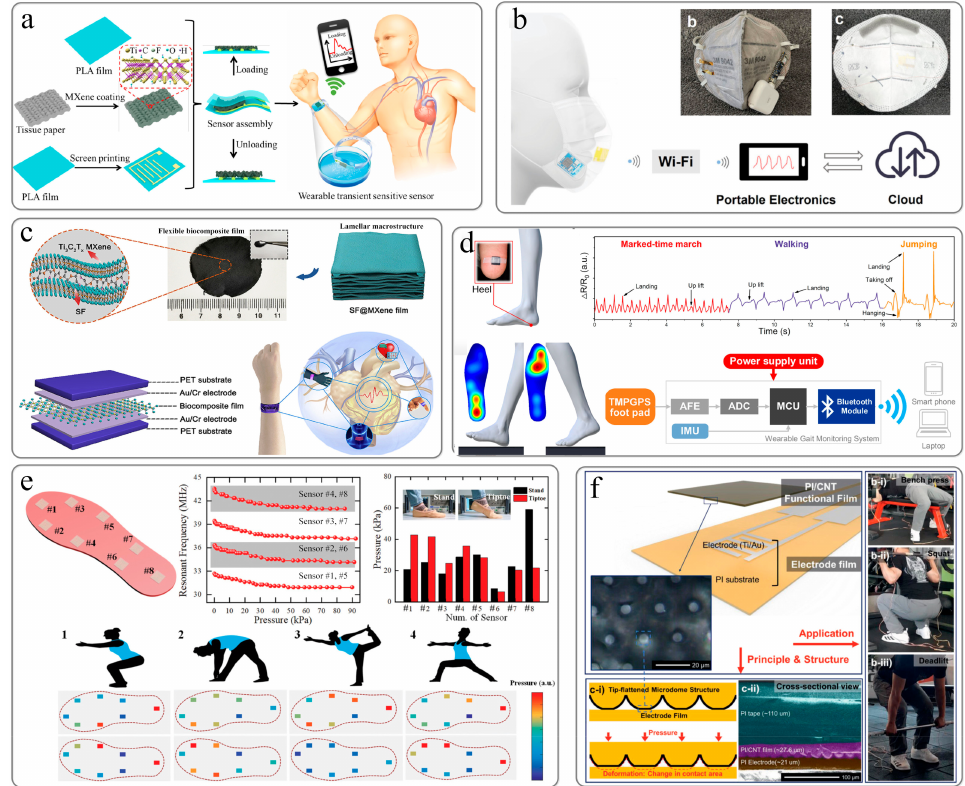
Figure 6. Flexible pressure sensor for human health detection. ( a ) Pulse vibration.